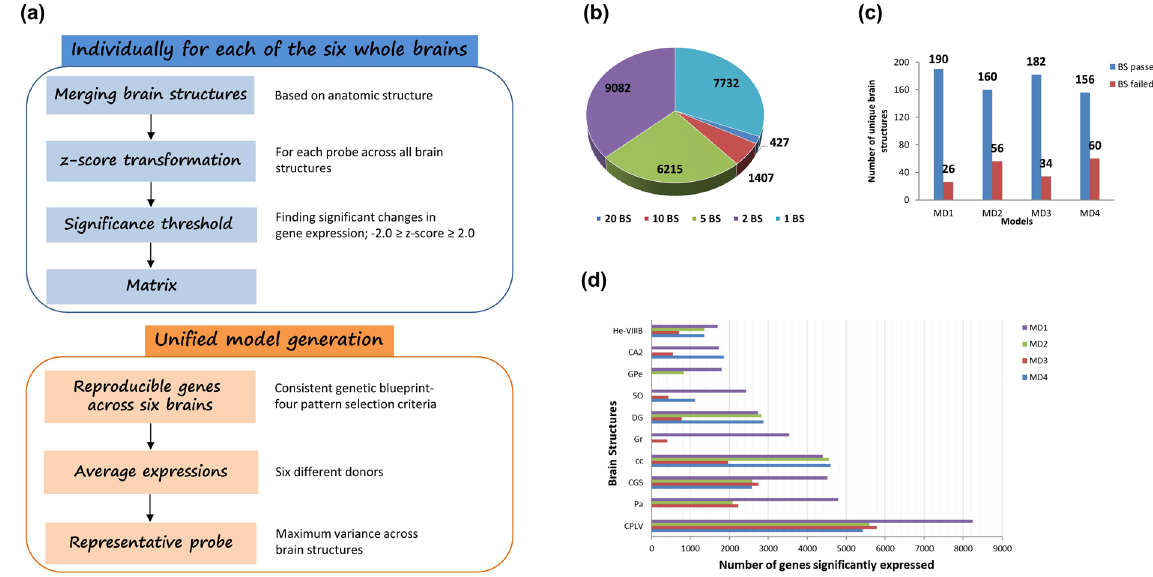
Figure 1. ( a ) Schematic of the building gene expression profile models for the healthy adult human brain. (b) Distribution of reproducible gene expression patterns across distinct brain structures for expression profile model, MD1. ( c) Number of unique brain structures (BS) that pass or fail the gene expression pattern selection criteria for models, MD1 to MD4. ( d ) Brain structure based gene enrichment. Top ten brain structures with highest number of genes showing significant and differential expression across four